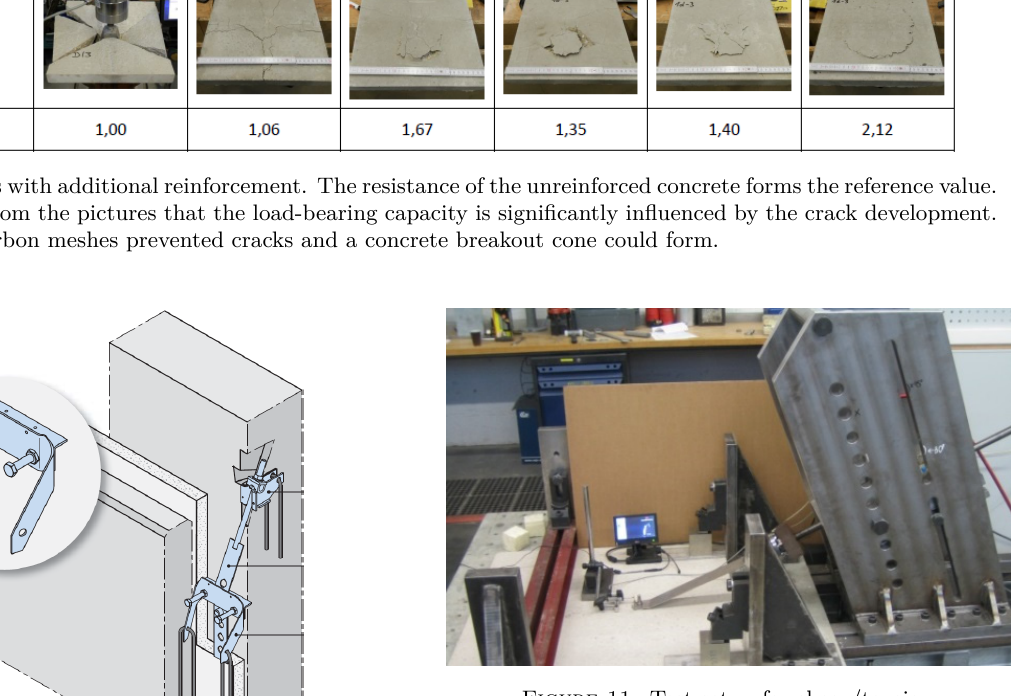
Figure 11. Test setup for